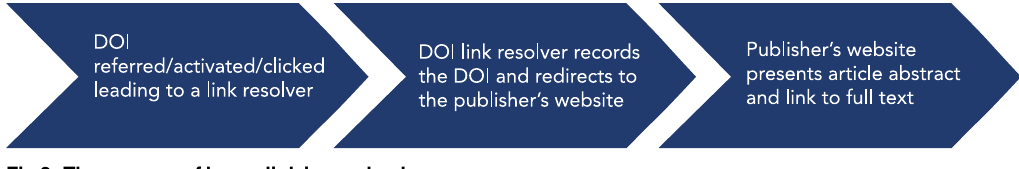
Fig 1. A citation with a DOI link from the references section of the Wikipedia page on Drug Prohibition Law to a scholarly article. The “DOI” in the link acts as https://dx.doi.org when referred (clicked).